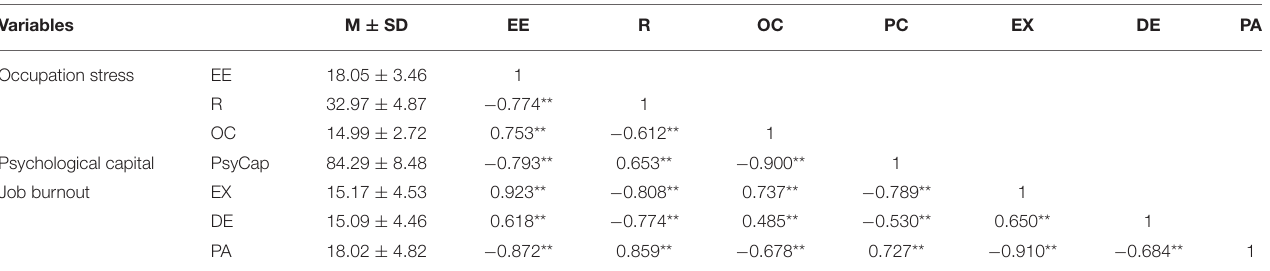
TABLE 2 | Correlation between occupational stress, psychological capital and job